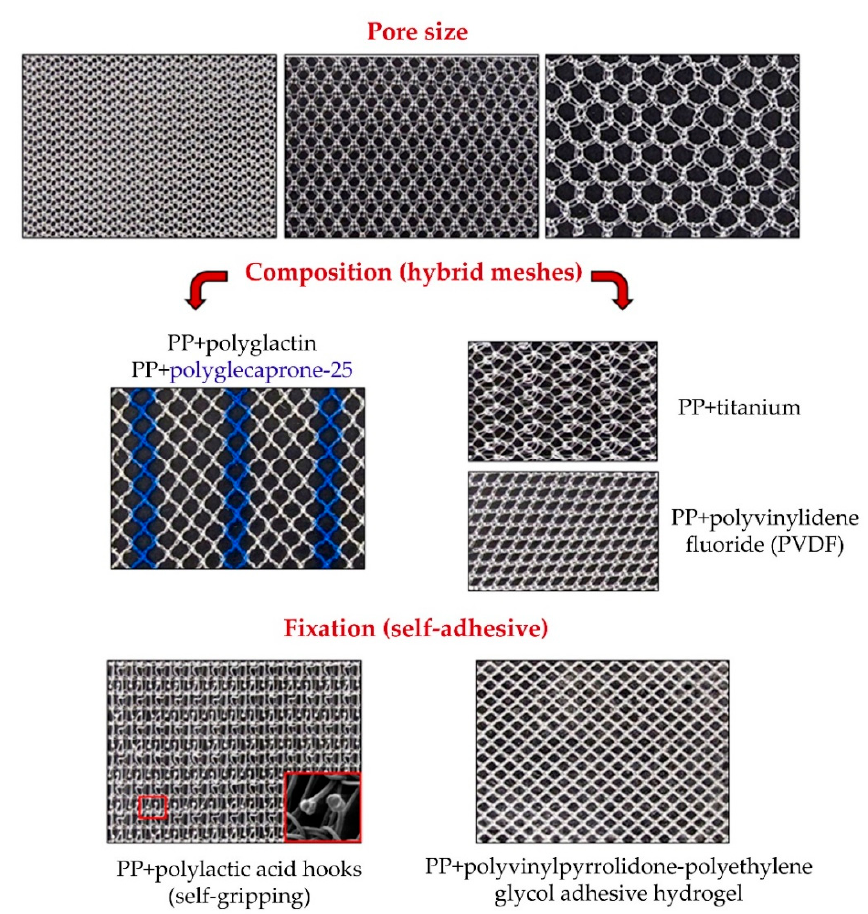
Figure 4. Macroscopic images of the different modifications to polypropylene meshes. Pore size: modifications in pore size have the objectives of minimizing minimize the quantity of foreign material in the host tissue, and improve the foreign body reaction and fibrosis without compromising mechanical resistance. Composition: hybrid meshes combine different components knitted or woven together to obtain a single mesh structure. Some of them incorporate an absorbable component (polyglecaprone-25 or polyglactin) to diminish the fibrosis reaction and amount of foreign material left in the body. Others include titanium or polymers like polyvinylidene fluoride. Fixation: self-adhesive meshes strive to achieve atraumatic mesh fixation (red box: polylactic acid hooks, scanning electron microscopy, 16x).